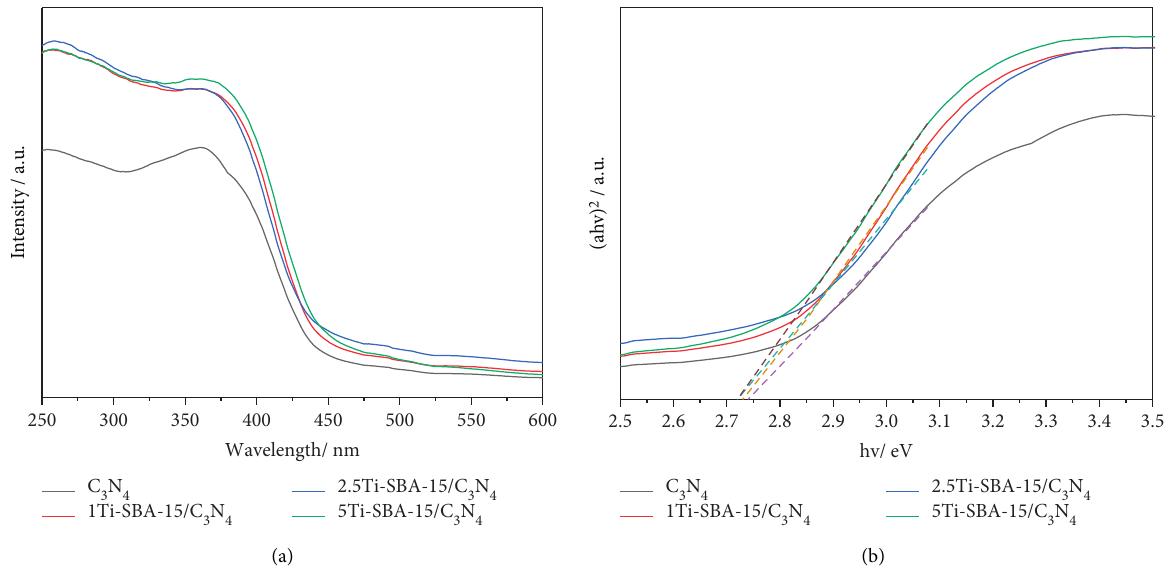
Figure 3: UV-DRS spectra (a) and Tauc plot (b) of pure C